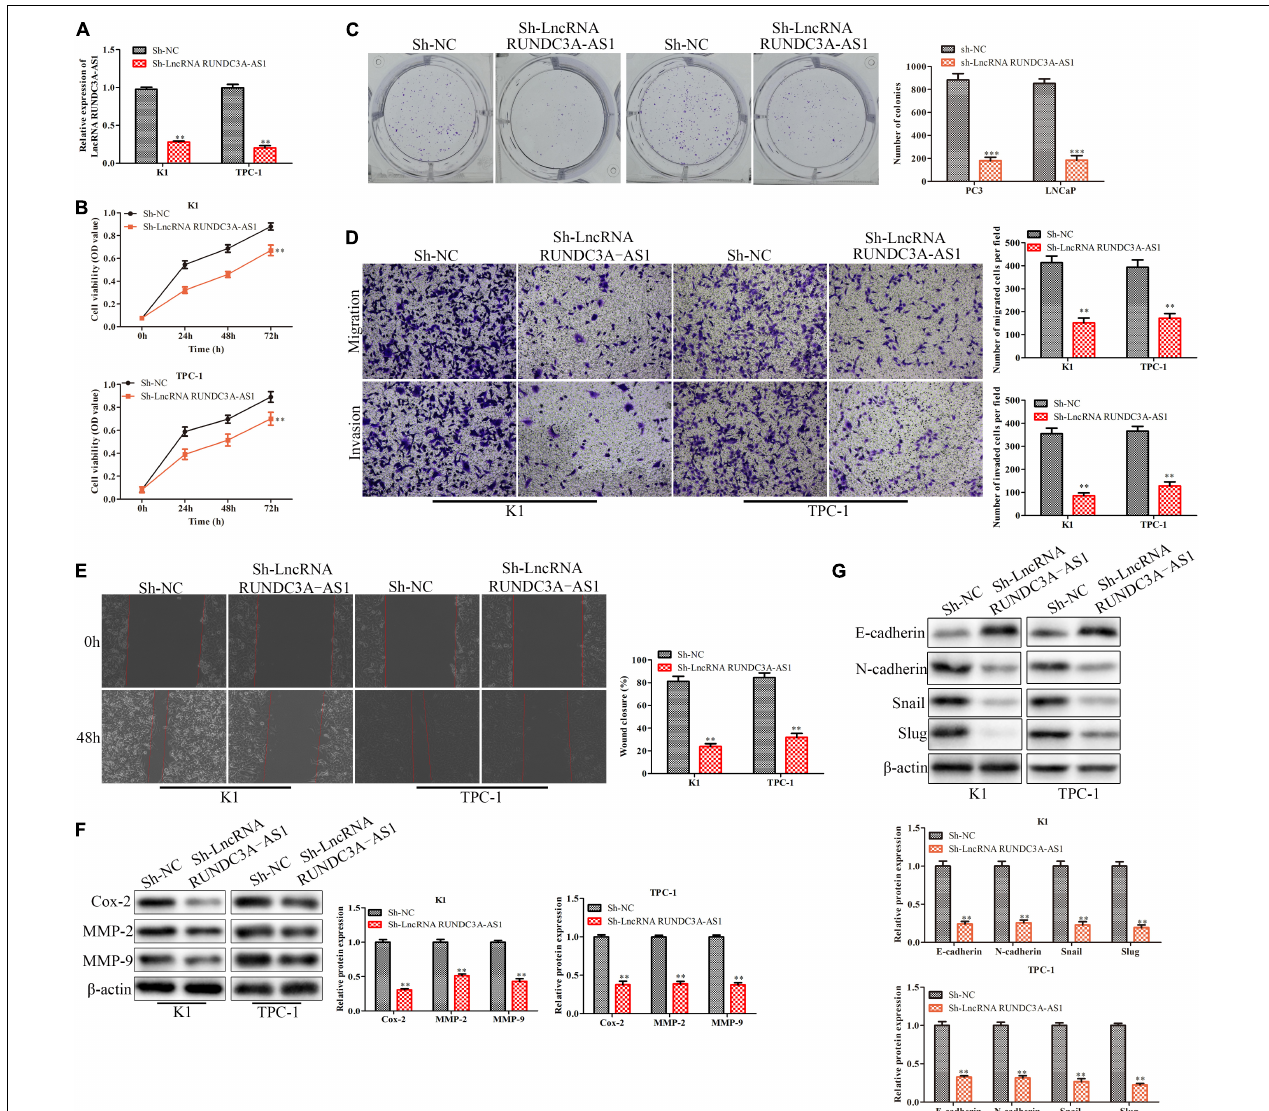
FIGURE 2 | Knockdown of RUNDC3A-AS1 represses proliferation, migration and invasion of thyroid cancer cells in vitro. K1 and TPC-1 cells were transfected with either RUNDC3A-AS1 shRNAs or negative control (NC) shRNAs. (A) RT-qPCR analysis of the cell transfection. (B) CCK-8 assay for cell viability. (C) Clone formation assay for cell proliferation. (D) Transwell chamber assay for cell migration and invasion. (E) Cell capacity of migration (scratch test). (F) Western blot analysis of the expression levels of migration related proteins (Cox-2, MMP-2, and MMP-9). (G) Western blot analysis of the expression levels of epithelial mesenchymal transition (EMT) marker proteins (E-cadherin, N-cadherin, Snail, and Slug). ** P < 0.01, *** P < 0.005 vs. the sh-NC group. The data were presented as mean ± SD and the experiments were repeated 3